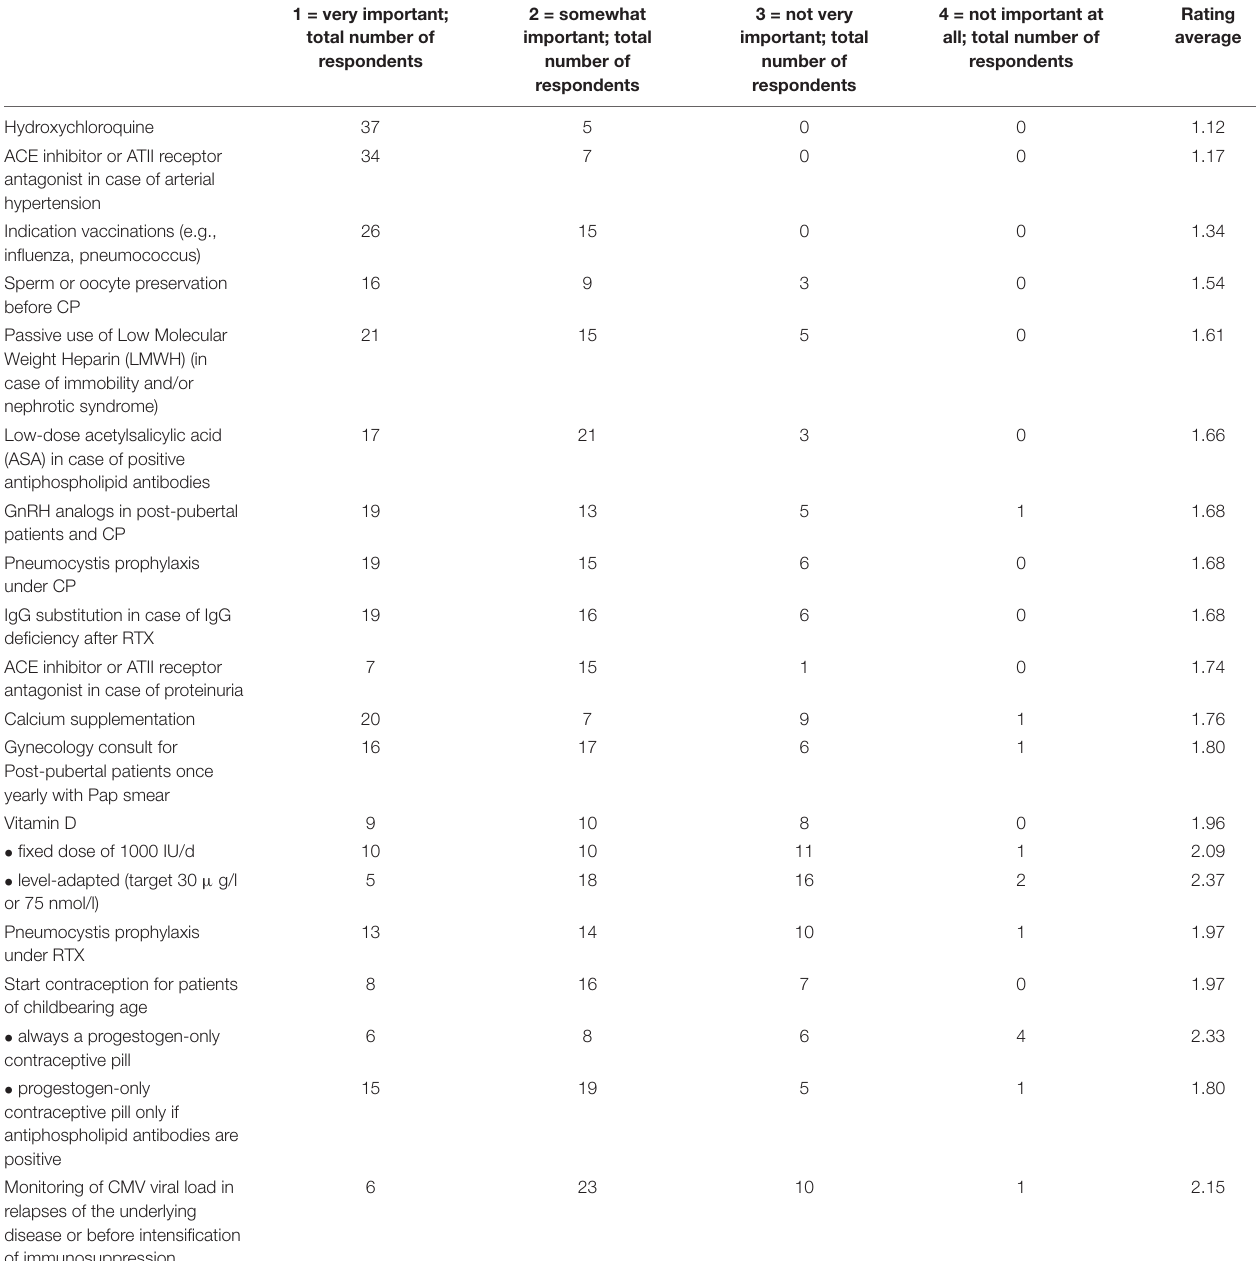
TABLE 7 | Useful concomitant therapies or preventive measures in patients with lupus nephritis (answers by Likert scale: 1 = very important, 2 = somewhat important, 3 = not very important, 4 = not important at all; with rating average of respondents). 1 = very important; total number